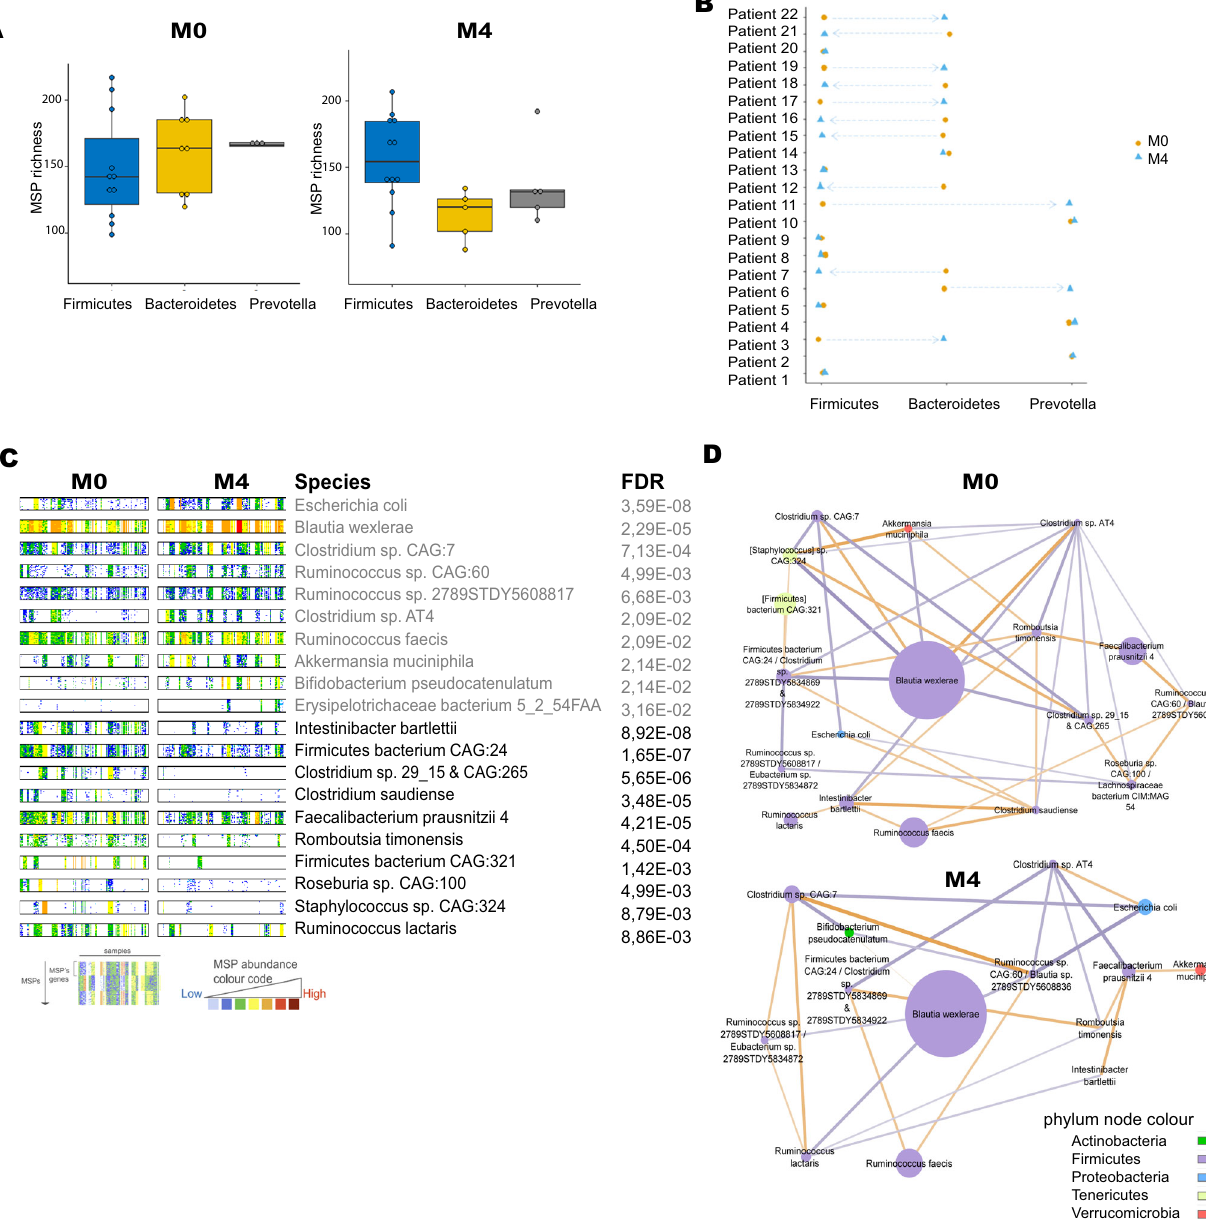
Fig. 1 Enterotype and microbial compositional changes. A Relation between MSP richness and enterotype before and after metformin treatment (M0 and M4).The boxplots depict minimum and maximum values; centre lines denote mean values; whiskers denote 1.5× the interquartile range; dots denote each patient. B Personalized enterotype for each patient before and after metformin treatment (M0 and M4). C Barcodes of signi fi cantly increased and decreased (Wilcoxon signed-rank test, FDR <0.05) MSPs between M4 and M0. Barcodes represent each sample in the group and respective gene counts of each gene clustered into MSPs. Sample size under analysis: 10 samples that are signi fi cantly increased and decreased after metformin treatment (M4). D Integrative correlation network (ICN) based on MSPs signi fi cance and Spearmen correlation between M4 and M0 (Wilcoxon signed-rank test, FDR <0.05). In the network, the orange edges correspond with a positive correlation whilst the purple edges correspond with a negative correlation. The nodes are coloured based on phylum level whilst the node size correspond with the abundance of each